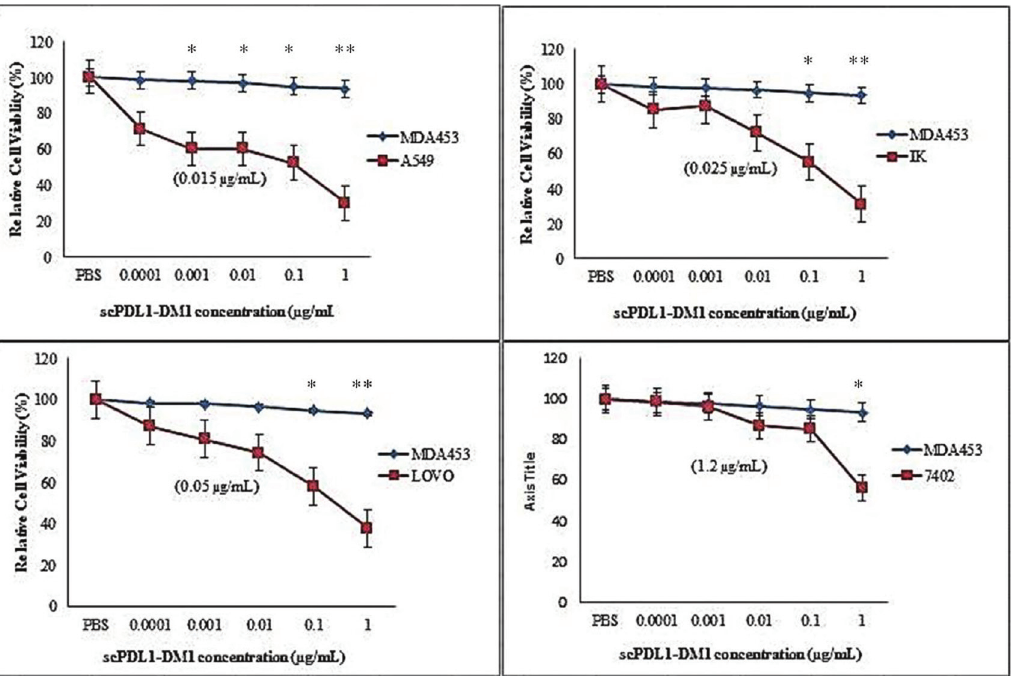
Figure4 -Cellviabilitydetectionafter48hoursbyMTTanalysis.ScPDL1-DM1conjugateinducesapotentantiproliferativeeffectinPD-L1positivetu- mor cells (A549, IK, LOVO, and 7402) but has no effect on PD-L1 negative MDA453 cells. MDA453 cells were used as control. These cells were incu- bated in 96 wells plate in drug conjugate for 48 hours. PBS was also used as a negative control. The IC50 values for each cell line are shown in parenthe- ses. The test experiments were repeated three times as indicated in standard bars. Oneway ANOVA was used to analyze the cell viability after 48 hours of cell treatment, **p<0.01, *p<0.05.